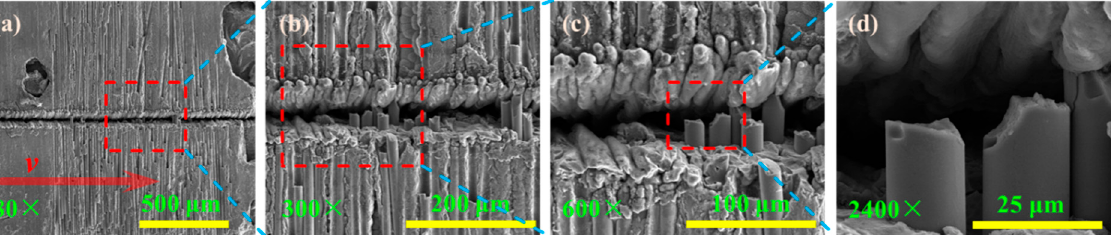
Figure 17. The grooved morphologies corresponding to different magnifications: ( a ) 80× magnifica- tions; ( b ) 300× magnifications; ( c ) 600× magnifications; ( d ) 200× magnifications. The relationship between grooving depth and grooving width at different repetition frequencies is shown in Figure 18 when the laser power is 14 W. It was found that trans- verse scanning (TS) has greater depth and narrower width than longitudinal scanning (LS). When the frequency is 3 kHz, the measurement deviation of transverse scanning depth is large. This is because the repetition frequency is smaller so that the energy density in the unit area is more concentrated, the number of pulses at the same time is smaller, and the spacing and depth of pulse points at the bottom of the tank are larger. The fluctu- ation range of measured values increases as the degree of unevenness increases (See Figure 5a). Longitudinal scanning of the grooved morphology shows that the depth on both sides of the bottom of the grooving is not equal (See Figure 5b). This is because when the beam irradiates to the bottom of the grooving, it is already in a positive defocusing state, and the energy density of the two laser beams from the beam splitter is not equal.